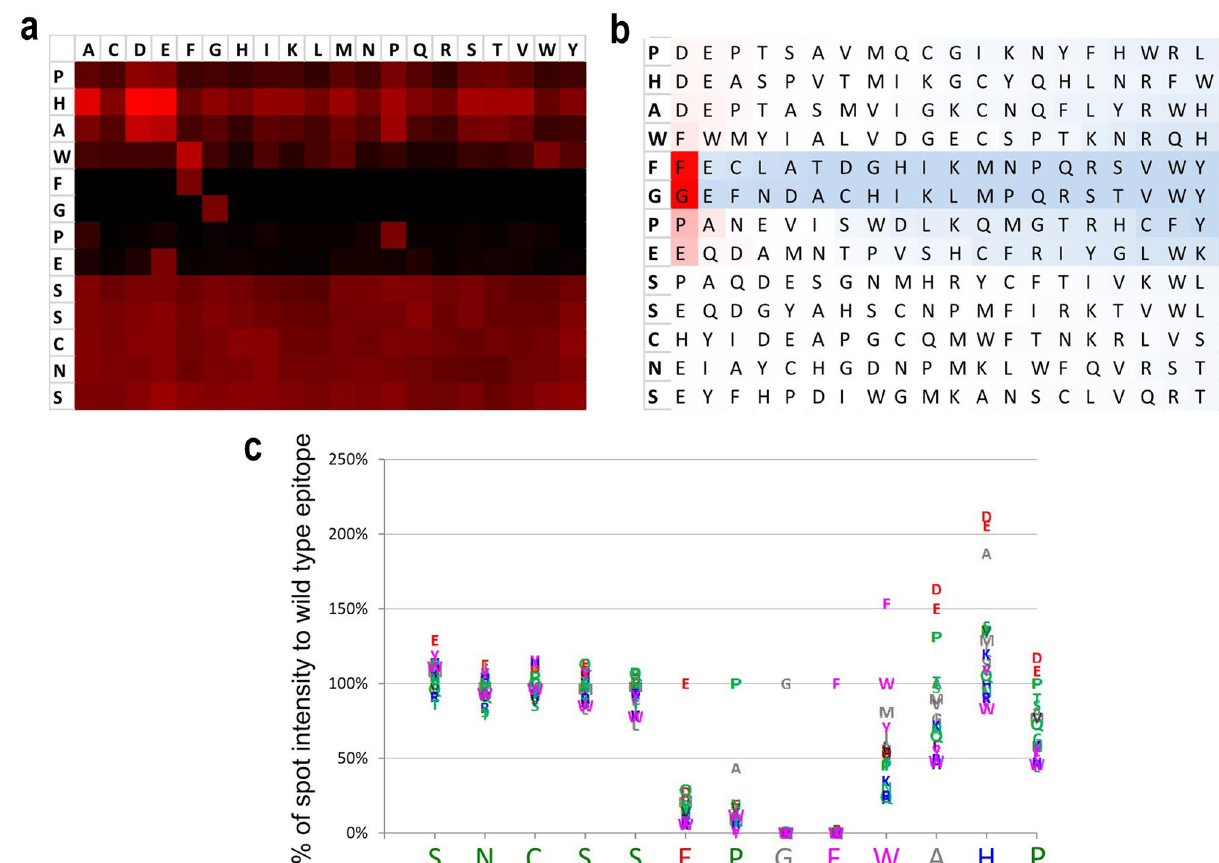
Figure 2. Epitope substitution assay. The heat map ( a ), substitution matrix ( b ) and amino acid plot ( c ) of mouse antibody M4M assayed against the substitution scan of cyclic constrained wild-type